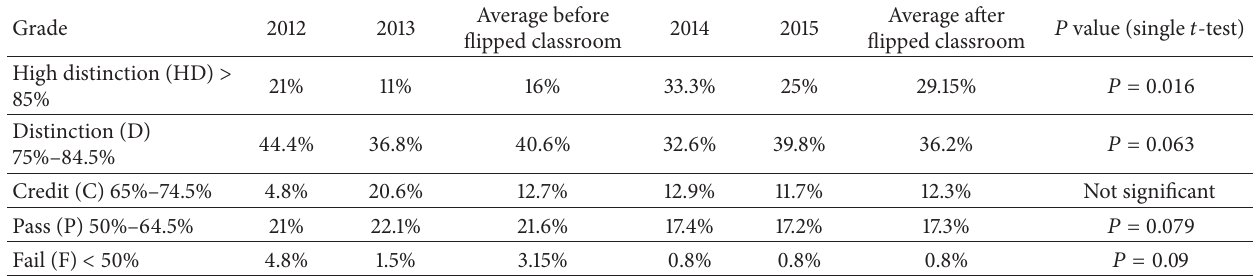
Table 6: Showing the distribution of the percentage of students awarded each different grade over the four-year period of the study, both before and after using the flipped classroom method.